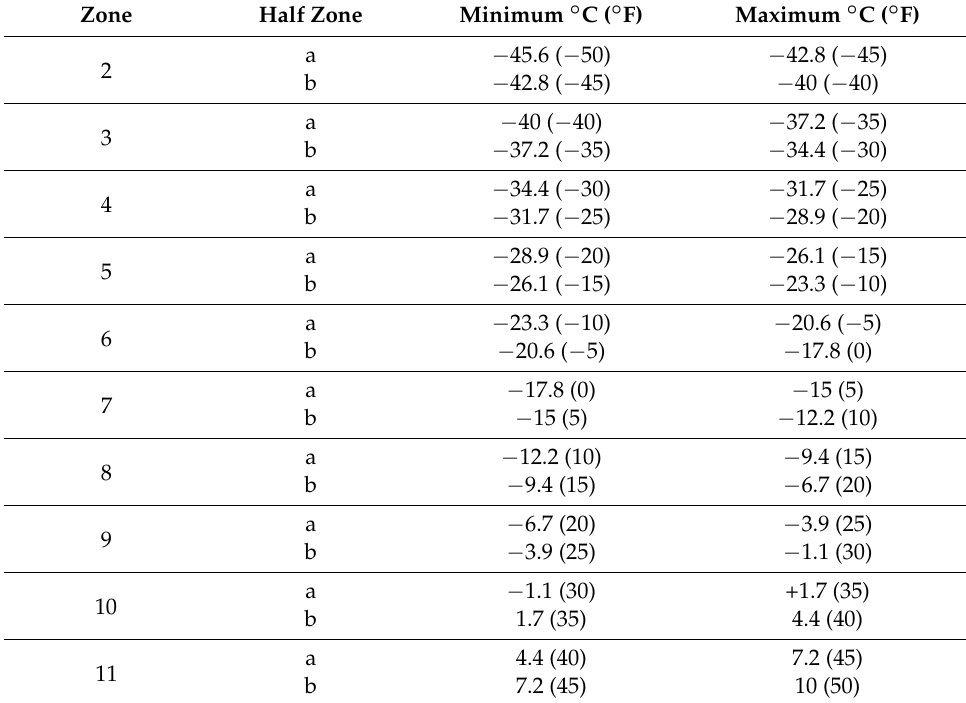
Table 1. Plant hardiness zones in the United States based on extreme daily minimum temperature during 30 years. Full zones are 5.6 ◦ C (10 ◦ F) and half zones are 2.8 ◦ C (5 ◦ F).